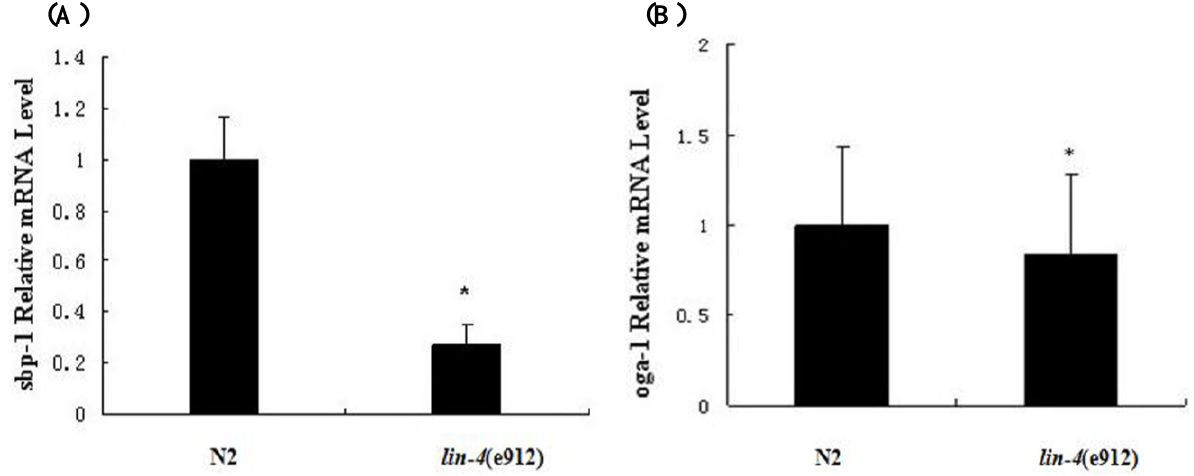
Figure 2. The expression of central regulation factors involved in fat storage control in nematodes. ( A ) Quantitative real-time PCR of sbp-1 in wild-type (N2) and lin-4 mutant (e912) worms. n = 50 ( n : number); ( B ) Quantitative real-time PCR of oga-1 in wild-type (N2) and lin-4 mutant (e912) worms. n = 40. Error bars indicate standard error. * p < 0.05.